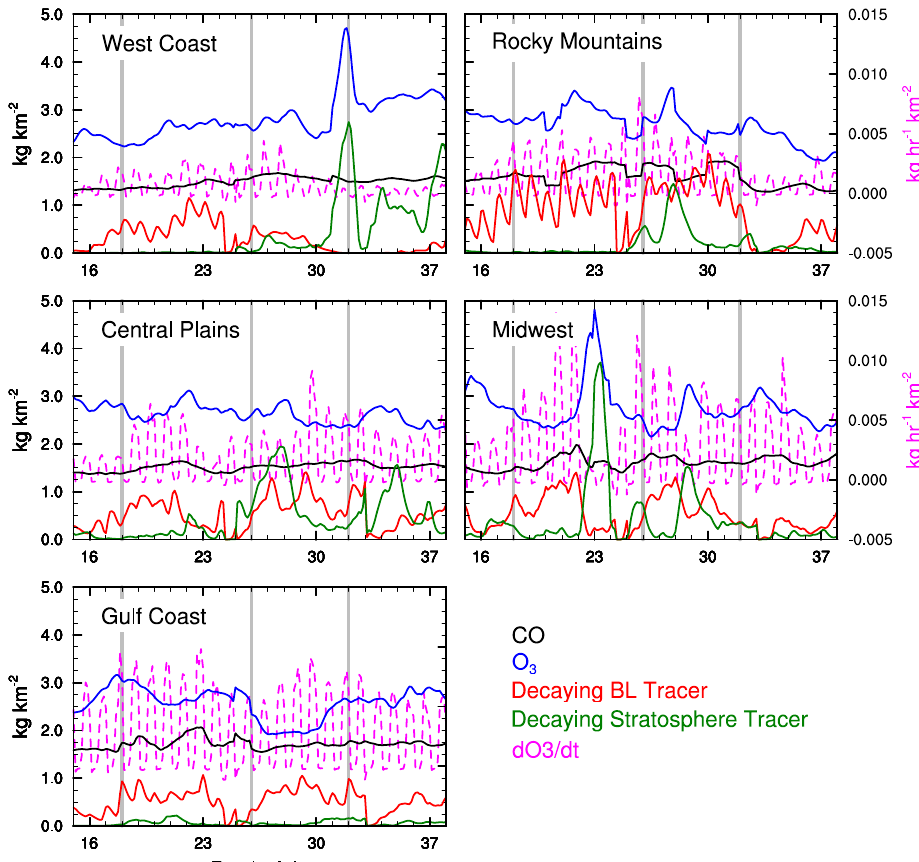
Fig. 10. Mass per unit area of CO (black line), O 3 (blue line), decaying boundary layer tracer (red line), decaying stratosphere tracer (green line), and chemical ozone tendency (dashed magenta line; right axis) in the upper troposphere (8–12km altitude range) over the (a) West Coast, (b) Rocky Mountains, (c) Central Plains, (d) Midwest, and (e) Gulf Coast regions of the model domain as shown in Fig 1. The decaying boundary layer scalar and decaying stratosphere tracer masses per area are the respective masses of air in units of 2 × 10 6 kgkm − 2 and 1 × 10 6 kgkm − 2 , respectively. The vertical gray lines delineate the 4 meteorological periods as described in the